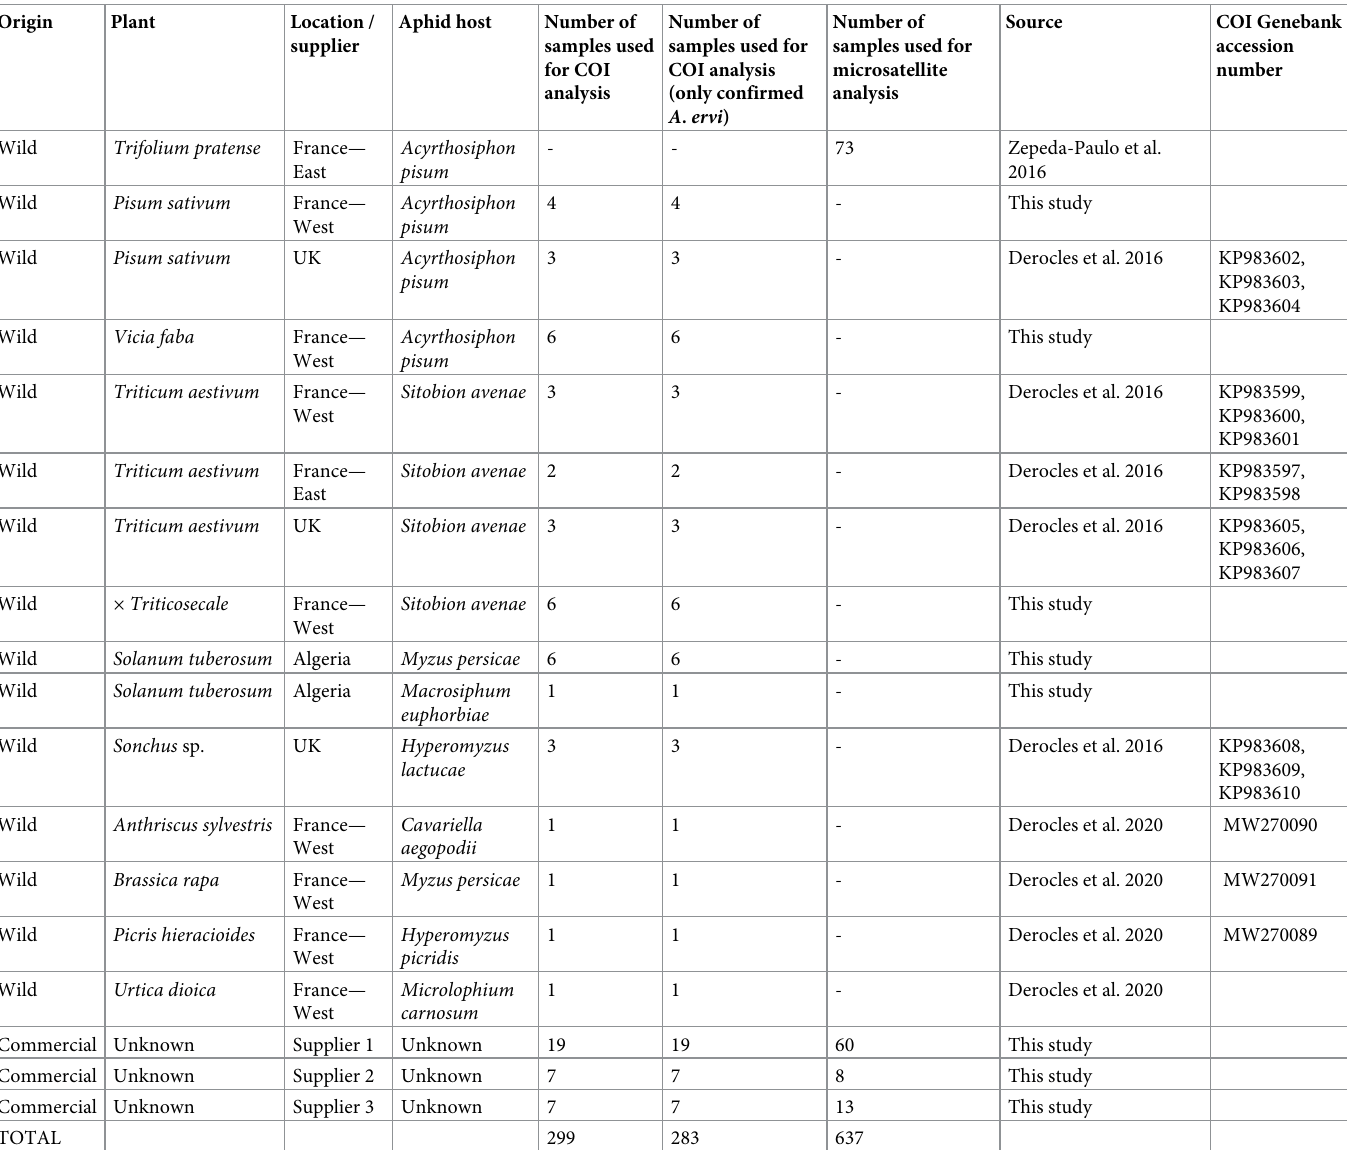
Diaeretiella rapae (Hymenoptera: Aphidiinae) (GenBank: JN620613.1) as outgroup. The best evolutionary model of sequences (HKY + I) was determined using jModelTest with the Akaike information criteria corrected for small sample sizes. To represent the genetic diversity of COI in A . ervi , a Median Joining haplotype network [28] was constructed using PopART v.1.7 [29]. Microsatellite